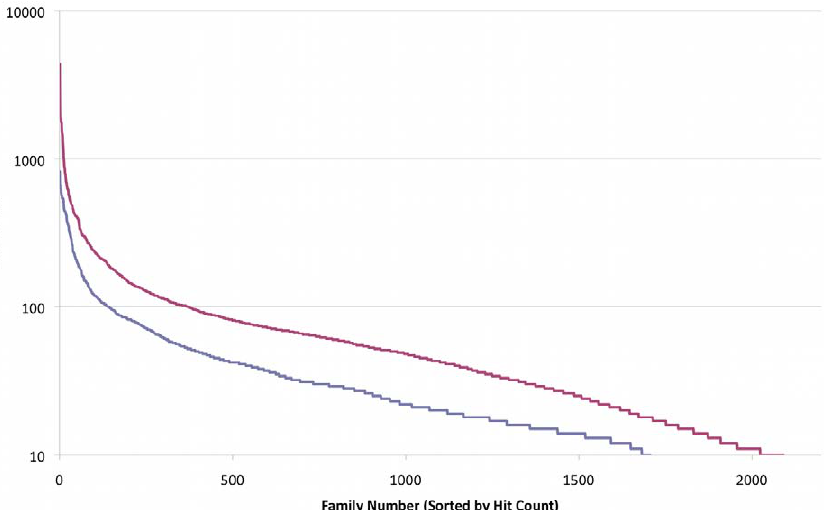
Figure 2. Size distribution of protein families in human gut metagenomics data, PfamA protein families (red) and new families found in this work (blue).